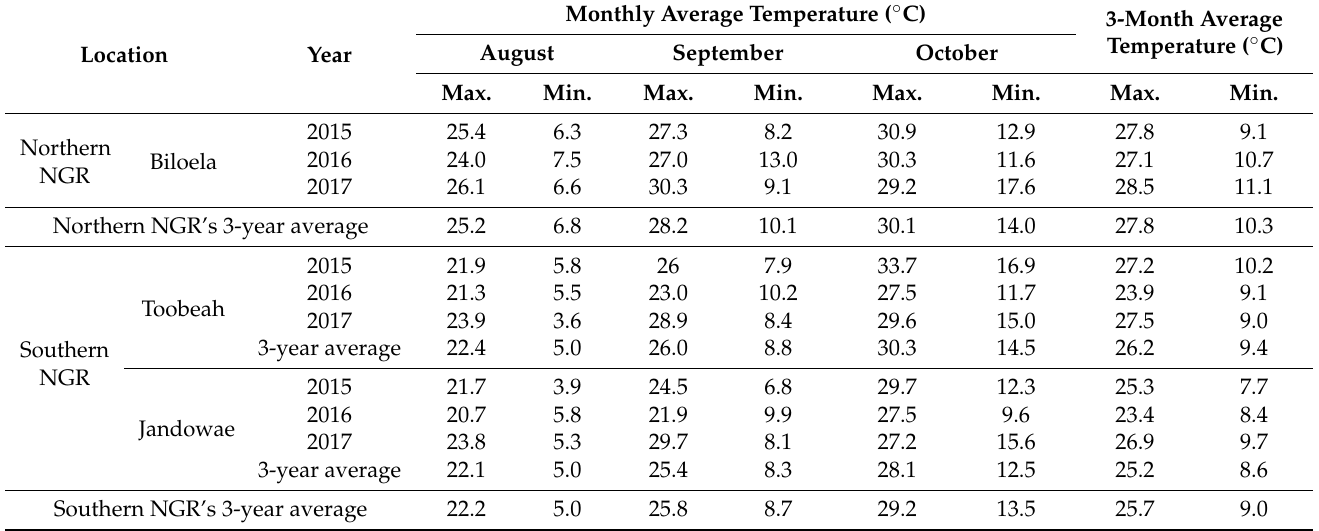
Table 5. Monthly average temperature ( ◦ C) of the seed collection sites of Avena sterilis ssp. ludoviciana biotypes during their seed development time from August to October. The temperature data were collected from the nearest weather station of the seed collection sites (source: Bureau of Meteorology, Australian Government; www.bom.gov.au; accessed on 15 July 2021). The data were taken from 2015, 2016 and 2017 to understand temperature effect on the parent seeds and to interpret the experimental results. Monthly Average Temperature ( ◦